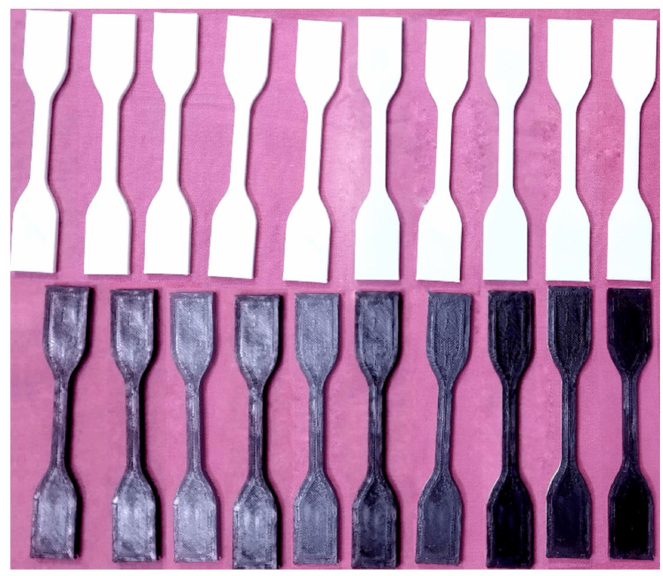
Figure 21. 3D printed specimens.